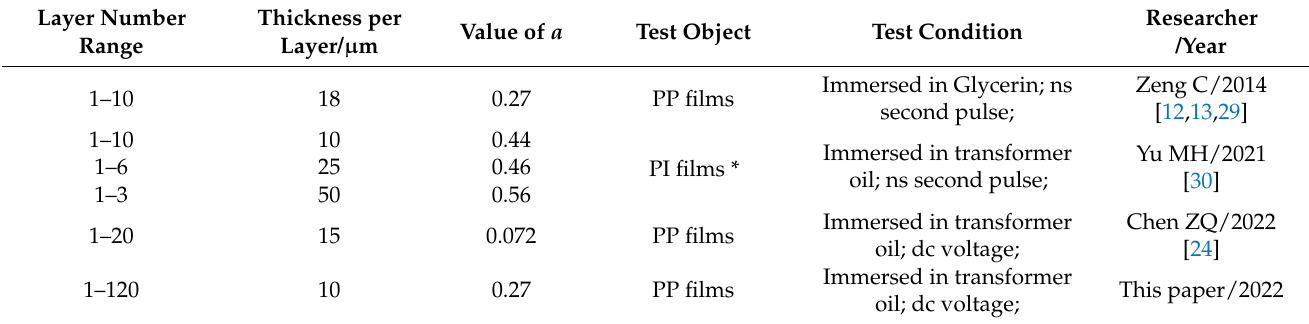
Table 2. Different groups of E BD ~ n